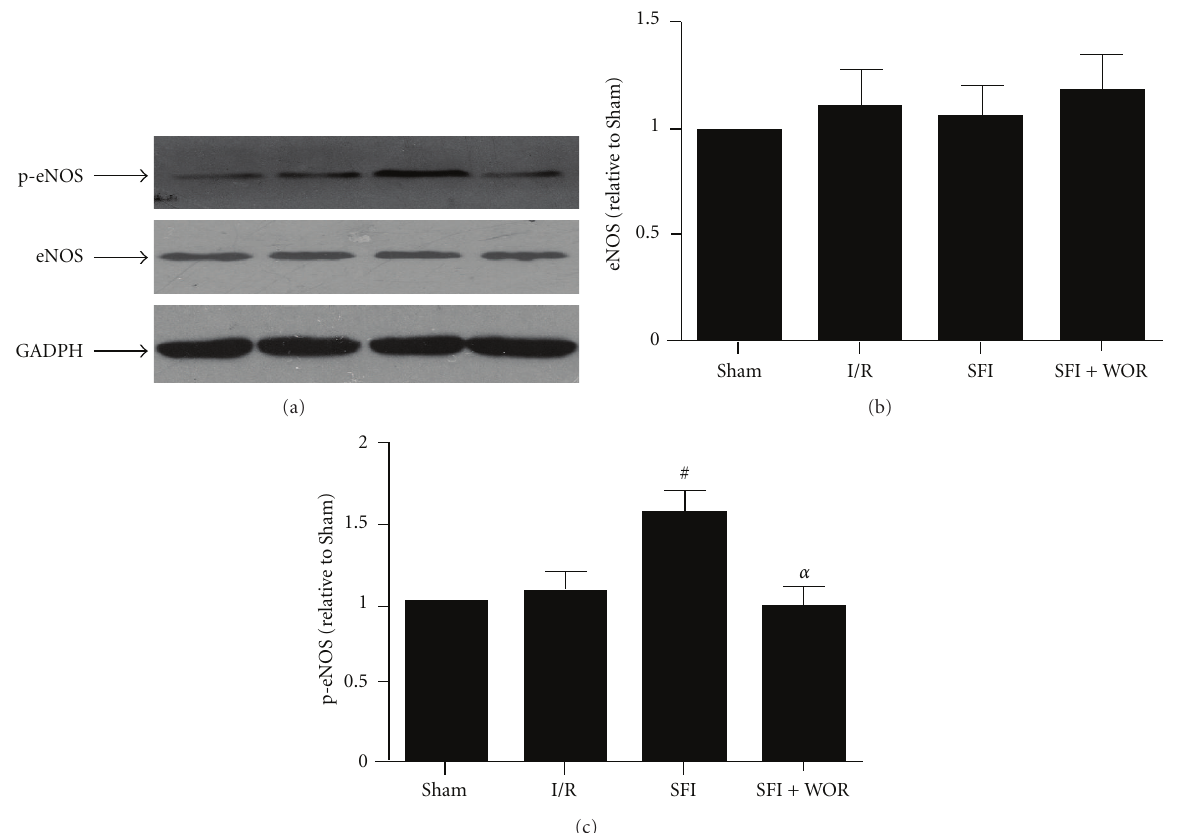
Figure 6: Immunoblots and graphs showing the protein levels and fold increases in total and phosphorylated eNOS from Sham, I/R, SFI, and SFI+WOR groups, respectively. I/R: ischemia/reperfusion; SFI: Shen-fu injection; WOR: wortmannin. Values presented are mean ± SEM. n = 6, # P < . 05 versus I/R, and α P < . 05 versus SFI.